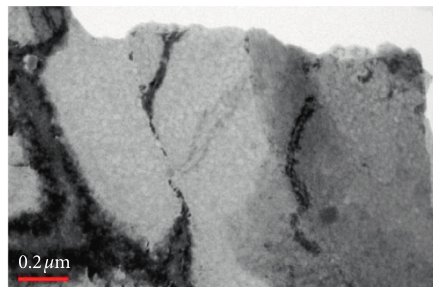
Figure 16: TEM image for the brazed